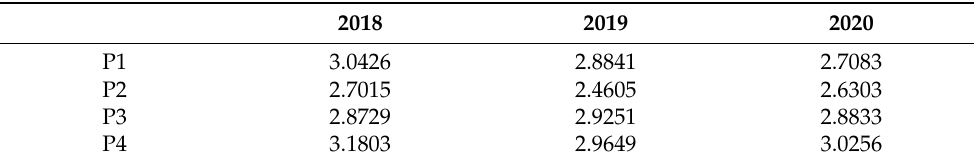
Table 1. The Shannon–Wiener diversity of the four permanent plots (P1–P4) in the “Pócalja” Nature- 2000 loess grassland (Central Hungary), during three consecutive years.